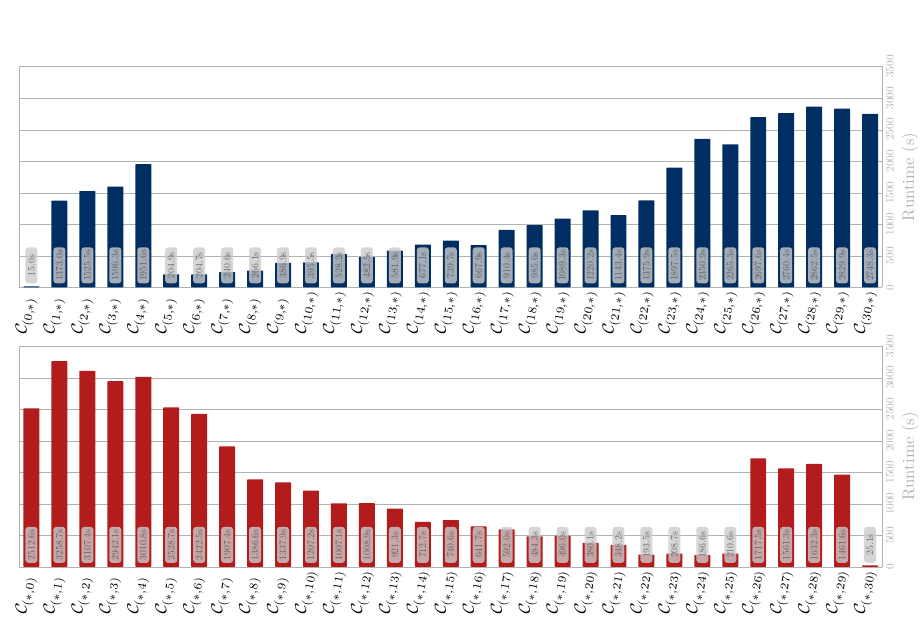
and C for PRESENT ( r, ∗ ) ( ∗ ,r )